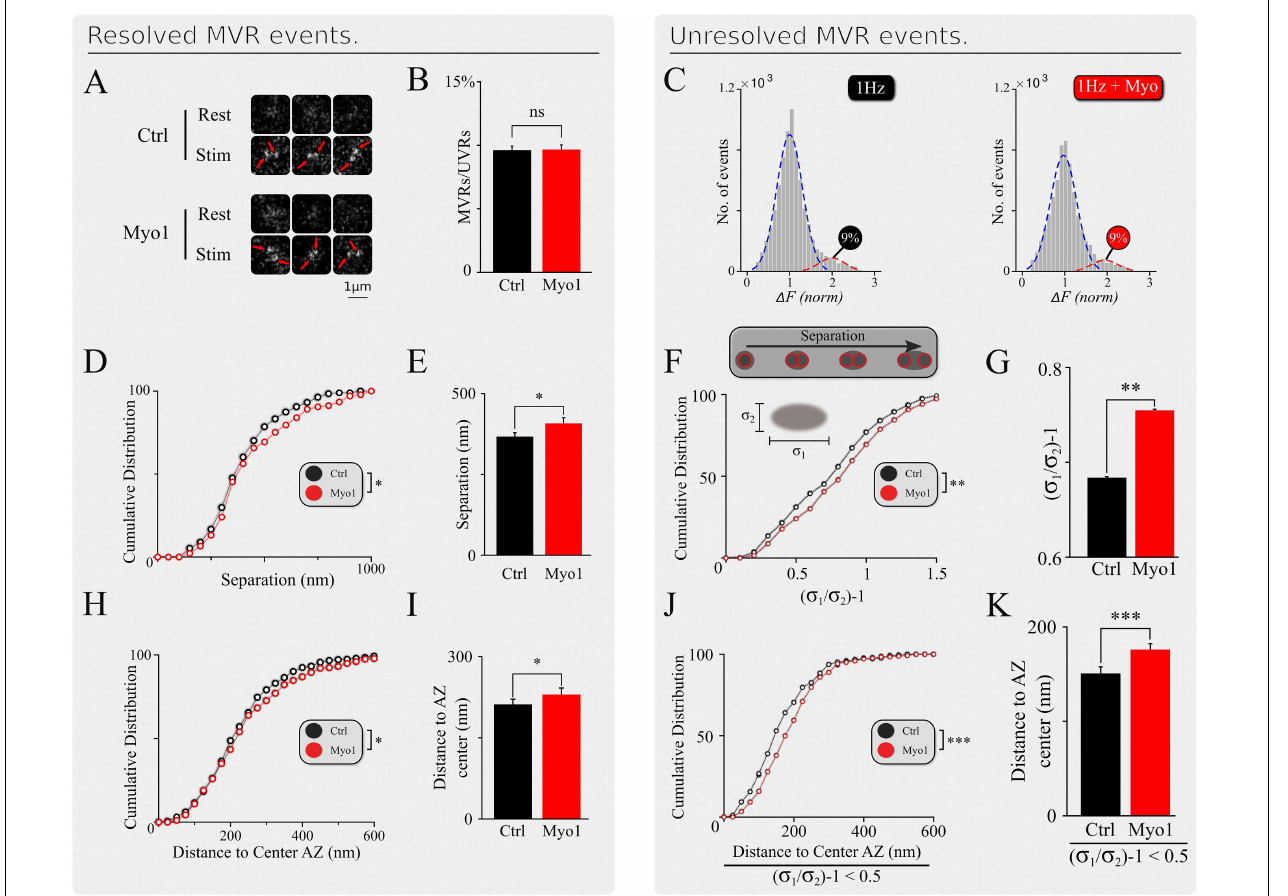
FIGURE 2 | Spatial organization of MVR events is myosin-V dependent. (A) Examples of resolved MVR events in different boutons in control conditions (top) and cultures treated with Myo1 (bottom) for 20 min. Scale bar = 1 µ m. (B,C) Inhibition of myosin V with Myo-1 does not affect the ratio between detected MVR and UVR events for resolved (B) and unresolved (C) MVR events. For unresolved MVR events, ratio of UVR and MVR was calculated based on a multi-Gaussian fit (C) . (D,E) Effects of myosin V inhibition with Myo-1 on the distance between two fusion events comprising an MVR for resolved events. Cumulative plots (D) and mean values (E) are shown. (F,G) Same as (D,E) for unresolved MVR events. (H,I) Effects of myosin V inhibition with Myo-1 on the distance from MVR events to the AZ center for resolved events. Cumulative plots (H) and mean values (I) are shown. (J,K) Same as (H,I) for unresolved MVR events. Only a subpopulation of more symmetrical MVR events (asymmetry score < 0.5) were included in this analysis, because these more symmetrical events could be well-approximated by a single symmetrical Gaussian fit, making this analysis comparable to that of the resolved MVR events. Two-sample t -test (all panels). ∗ p < 0.05, ∗∗ p < 0.01, ∗∗∗ p < 0.001, ns, not